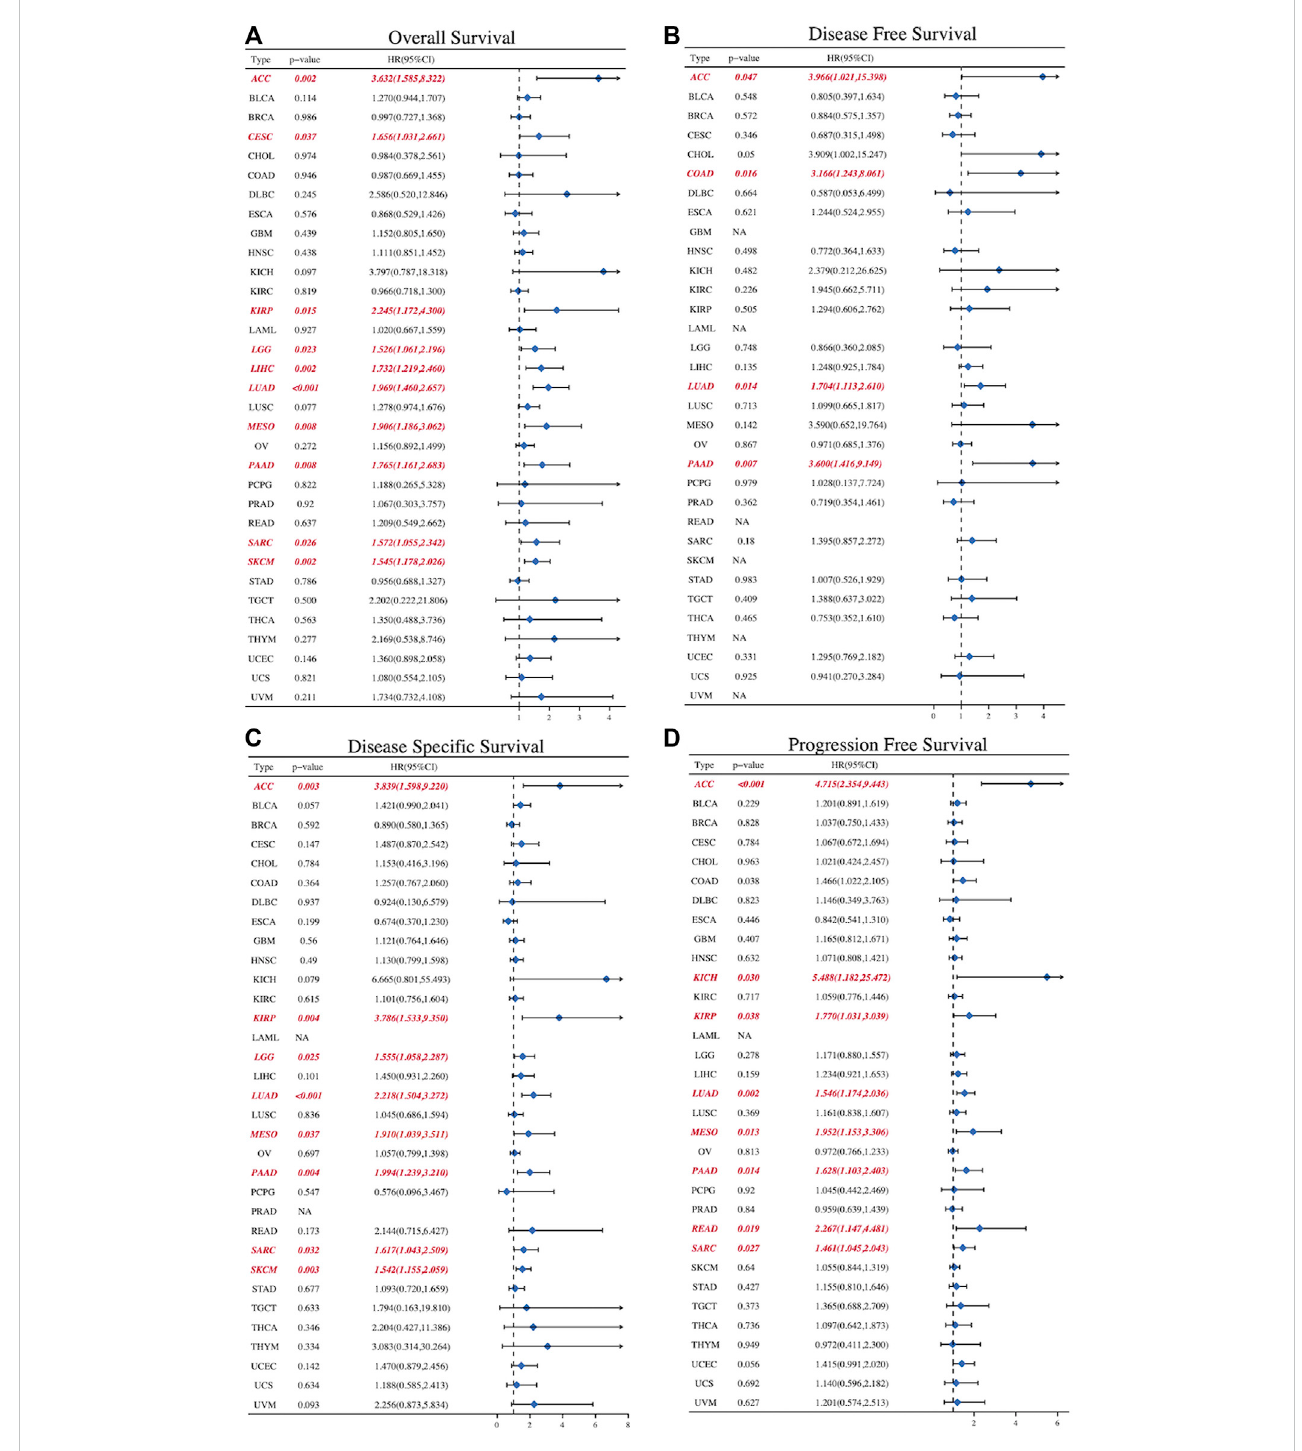
FIGURE 7 The forest diagrams of univariate Cox regression analyses in (A) OS (B) DFS (C) DSS, and (D) PFS. The red mark demonstrates that SLC2A1 expression was signi fi cantly associated with prognosis. That HR > 1 indicated that it served as a risk factor for survival. HR < 1 indicated that it had the protective effect on survival. OS, overall survival; DFS, disease free survival; DSS, disease speci fi c survival; PFS, progression free survival; HR, hazard ratio; CI, con fi dence